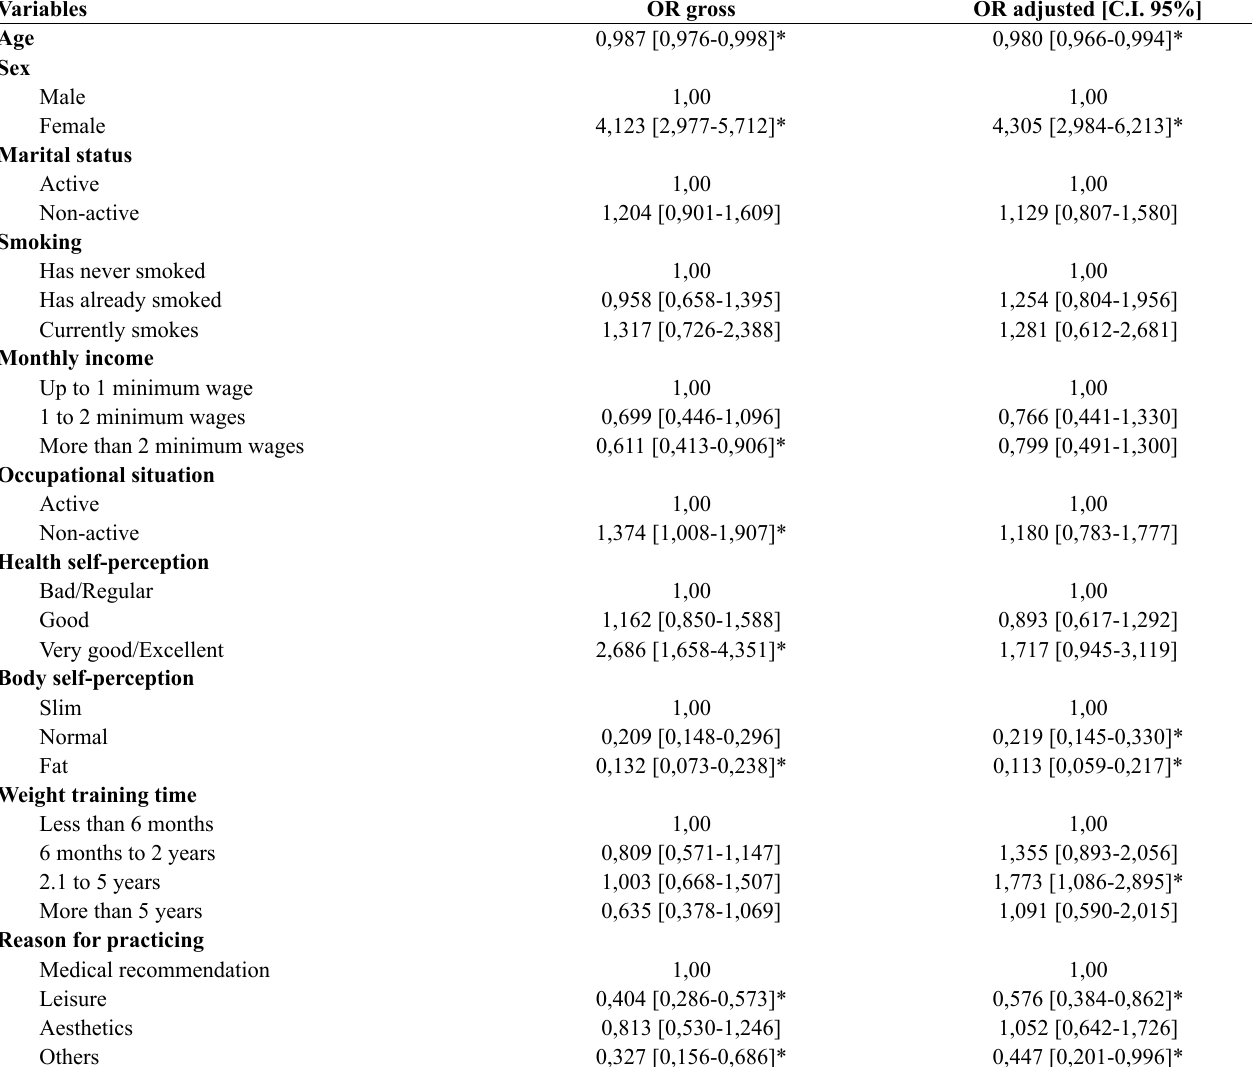
Table 5 . Factors associated with the presence of body image dissatisfaction of weight training practitioners in Maringá, Paraná, Brasil.